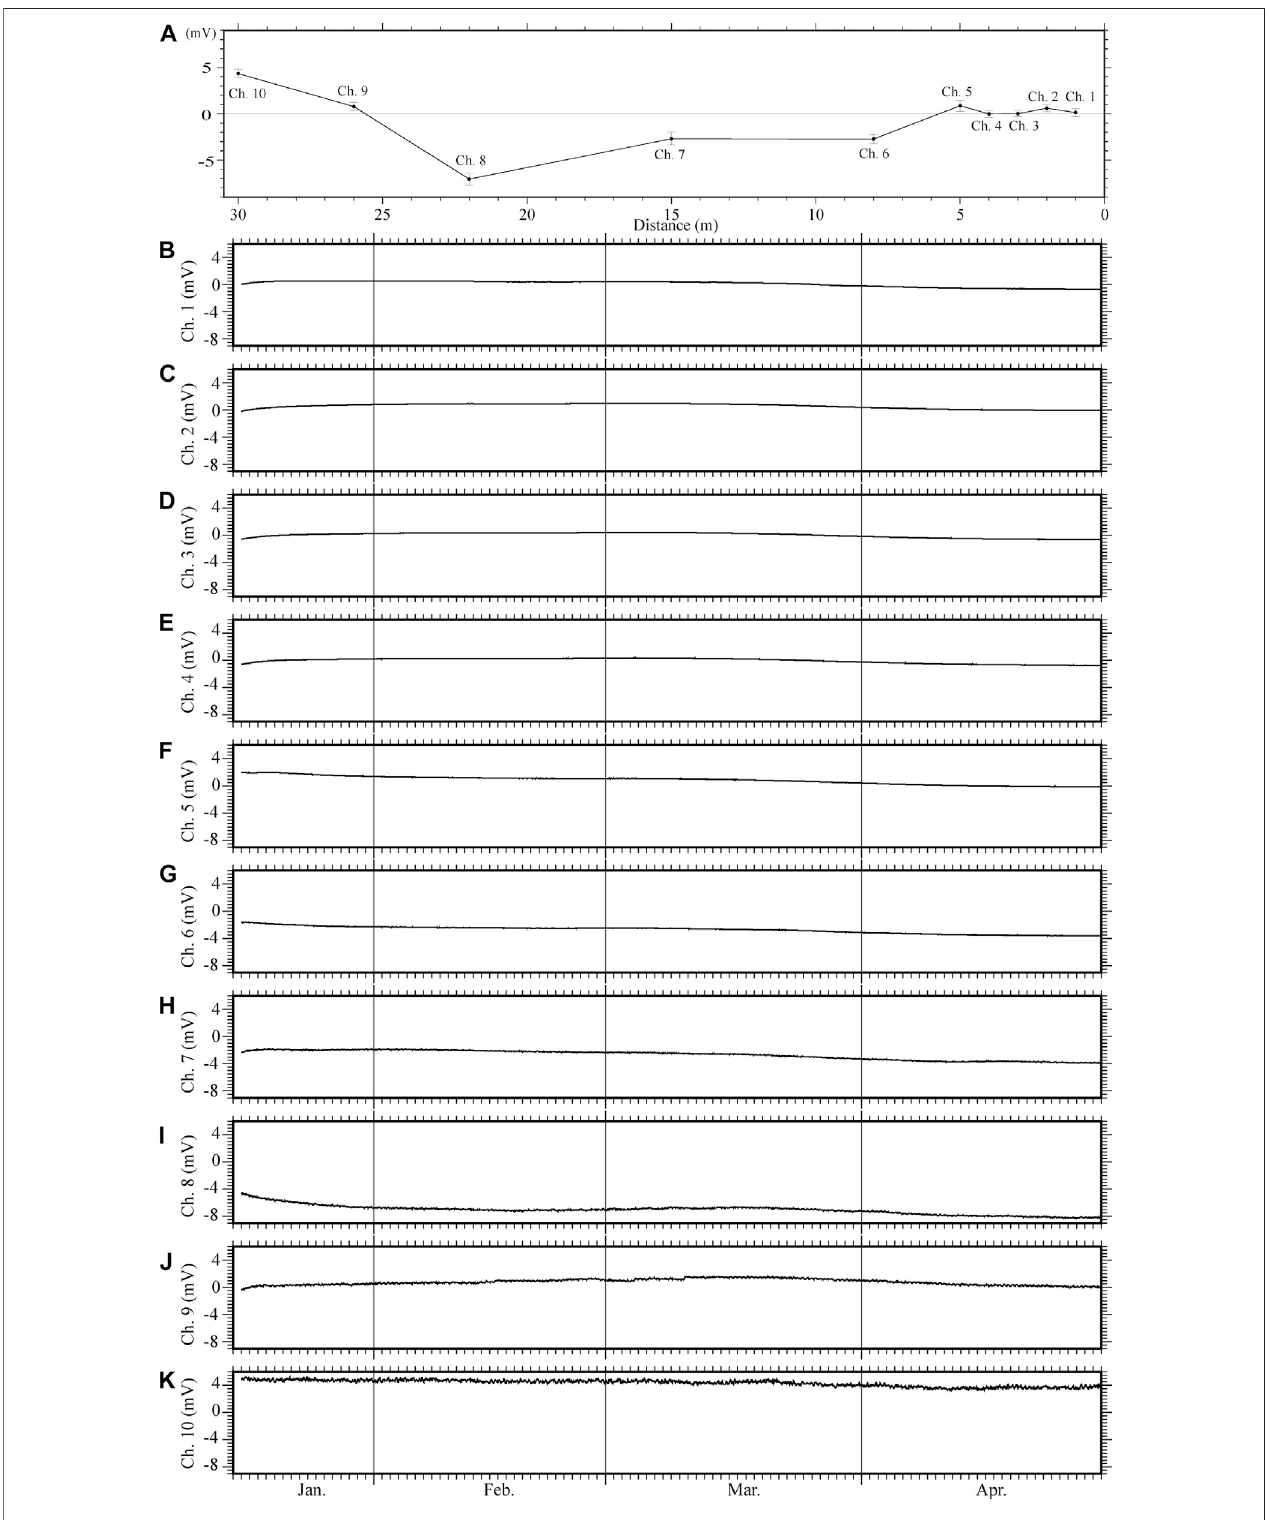
FIGURE 6 | (A) Spatial variation of the electric potential relative to the common electrode (averaged over the entire observation period). (B – K) Time series of 1 h average values for each electric potential relative to the common electrode throughout the observation period. For each electrode, the value immediately before installation was set to zero (the value measured in the period before installation was subtracted from the raw data).